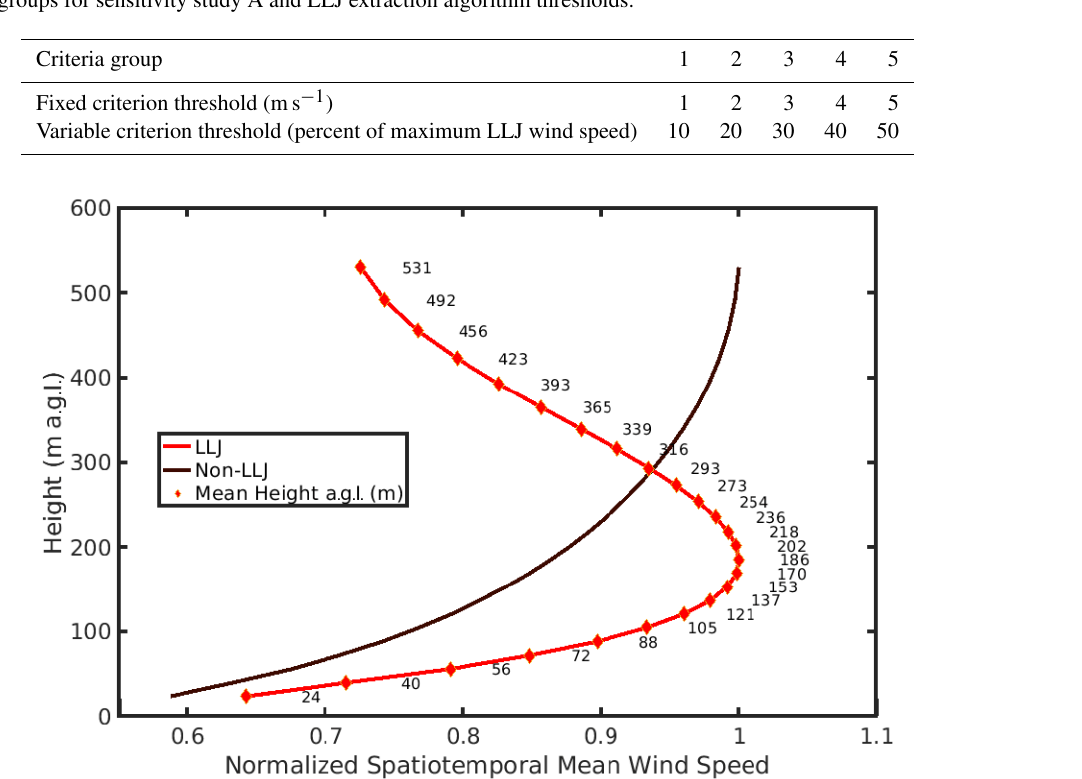
Table 2. Criteria groups for sensitivity study A and LLJ extraction algorithm thresholds.